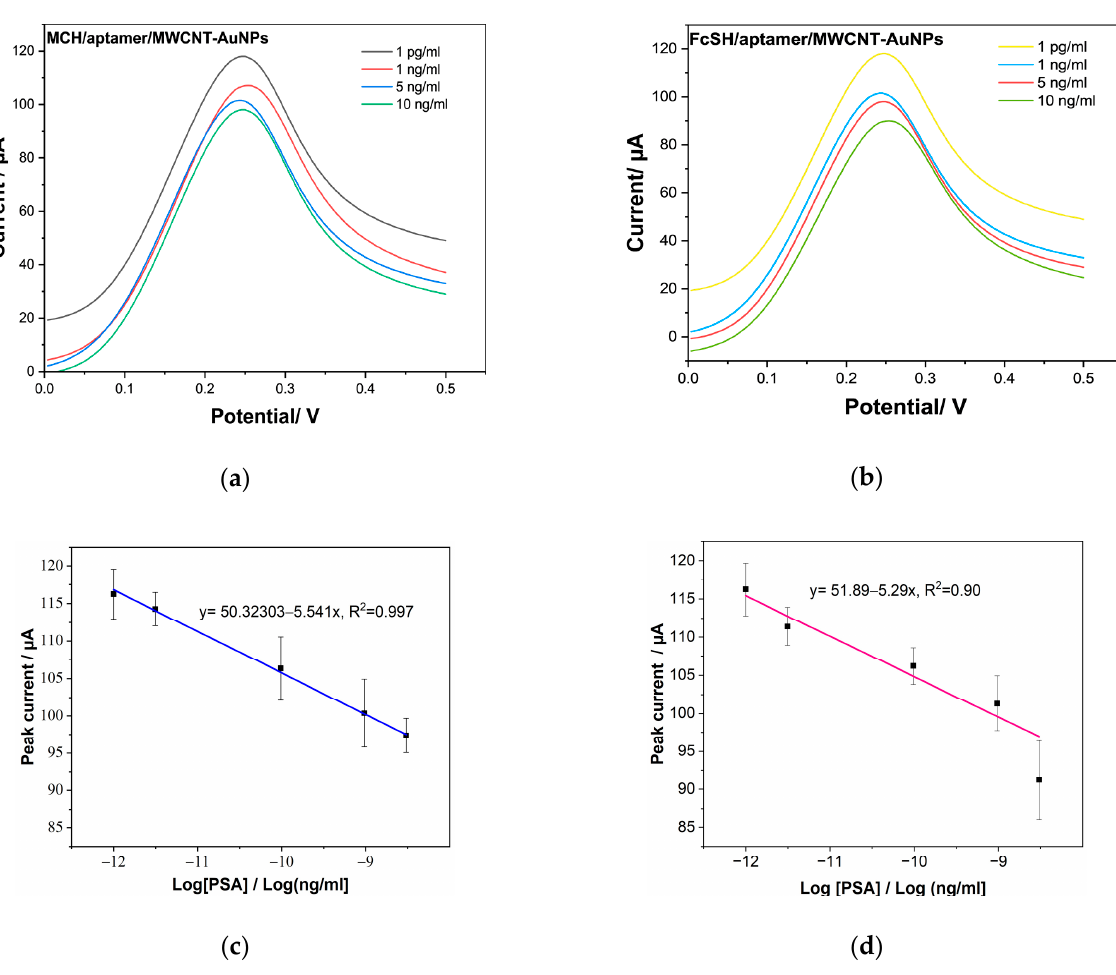
Figure 7. Linear variation in the obtained DPV current with log [PSA targeted concentration], ( a , c ) with slope = − 5.5 intercept = 50.32 and R = 99.7, n = 3 for PSA/MCH/aptamer/MWCNT. ( b , d ) with slope = − 5.29, intercept = 51.89 and R = 90.3 for PSA/FcSH/aptamer/MWCNT.